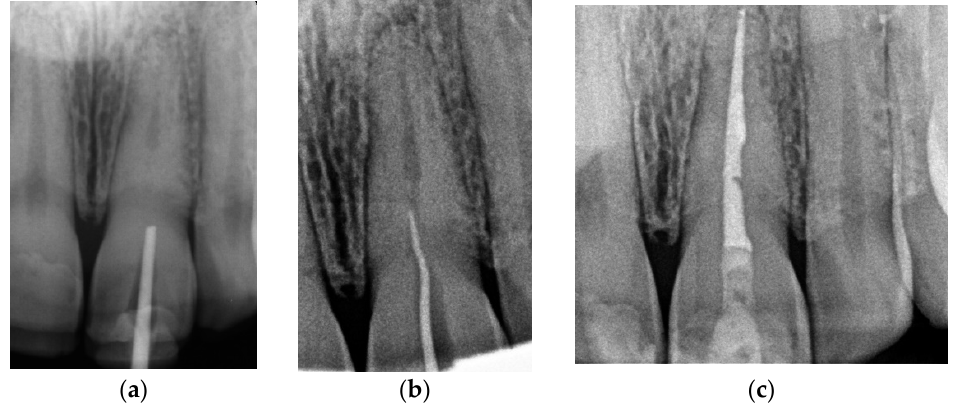
Figure 15. Radiographic examination was used to confirm ( a ) correct path of access pathway during procedure and ( b ) correct root canal access; ( c ) post-obturation radiograph.